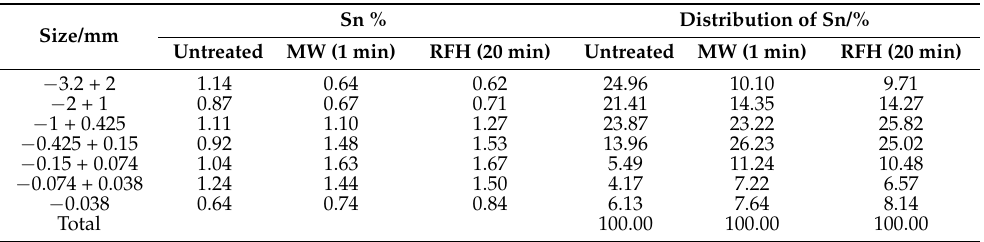
Table 10. Grade and distribution of Sn for each particle size range of the grinding